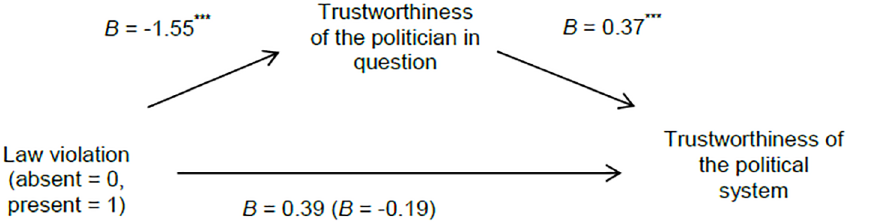
Figure 3. Indirect effect of the experimental condition on the perceived trustworthiness of the political system mediated by the perceived trustworthiness of the involved politician in Study 4. Note. N = 122. The figure displays unstandardized regression coefficients. The number in parentheses represents the coefficient for the total